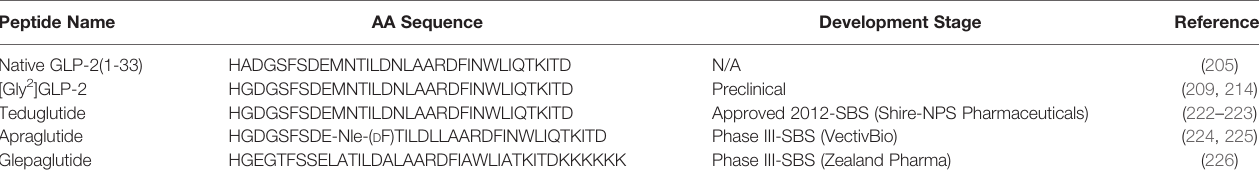
TABLE 3 | GLP-2-based therapeutic